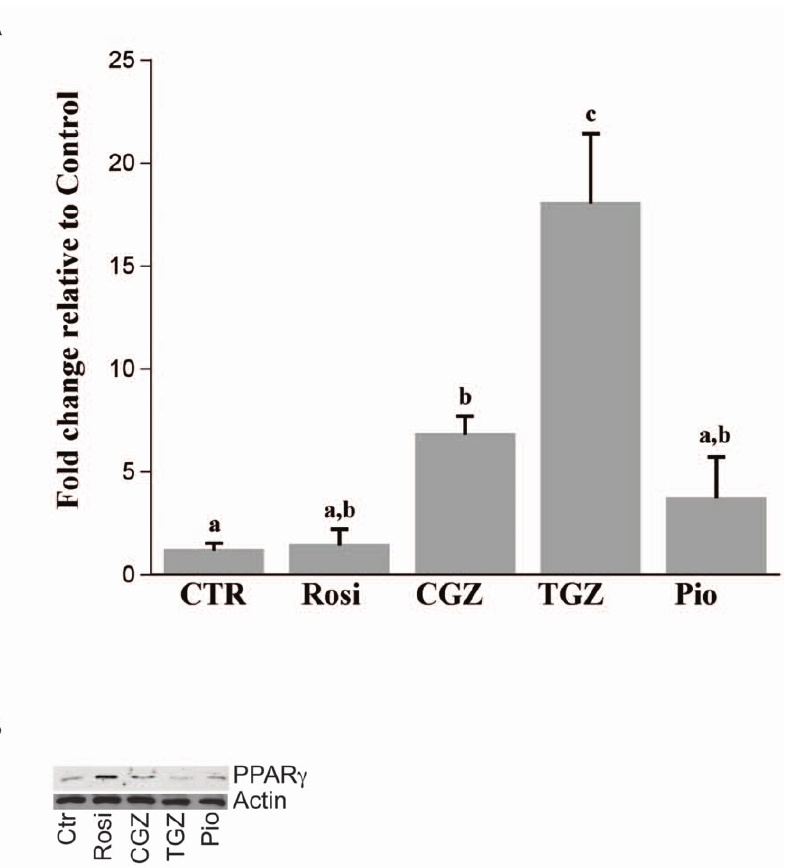
Figure 5. Effect of TZDs on PPAR c mRNA and protein expression. PPAR c mRNA and protein expression were measured in Ovcar3 cells using ( A ) Real time PCR and ( B ) western blot analysis after TZD treatment. Cells were serum starved for 24 hours and treated for an additional 24 hours with vehicle control (DMSO) or one of the following: 10 m M of Rosi, CGZ, TGZ, or Pio. Results are the means 6 SEM for at least 3 measurements from two individual experiments. Bars with different superscripts are significantly different ( p , 0.05).